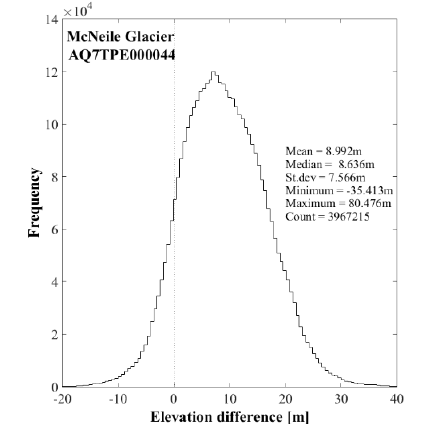
Figure 7. Histogram of elevation differences between archival 1957 and modern 2014 DEMs for McNeile Glacier (AQ7TPE000044).